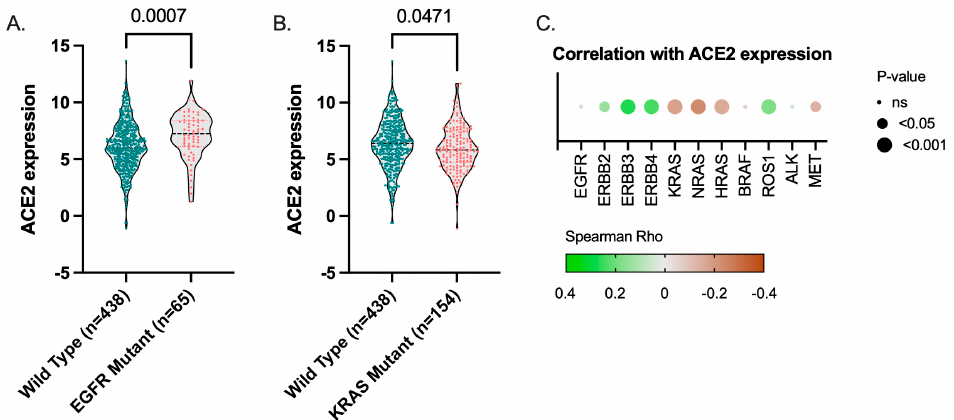
Figure 6. TCGA. ACE2 gene expression in ( A ) EGFR- and ( B ) KRAS-mutant TCGA LUAD tumors (RSEM, Log2). ( C ) Spearman’s correlation of ACE2 mRNA expression levels with EGFR/HER family members (EGFR, ERBB2-4), RAS (KRAS, NRAS, HRAS), BRAF, ROS1, ALK, and MET mRNA ex- pression.